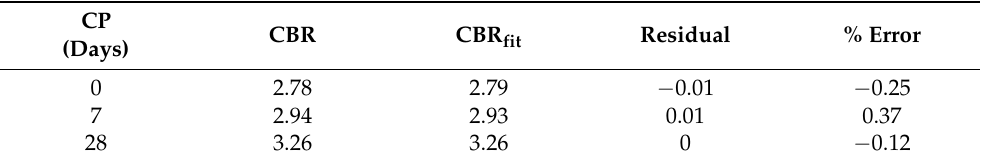
Table 2. The linear equation results for the California Bearing Ratio (CBR fit ) of untreated clay measured after 0, 7, and 28 days of curing.